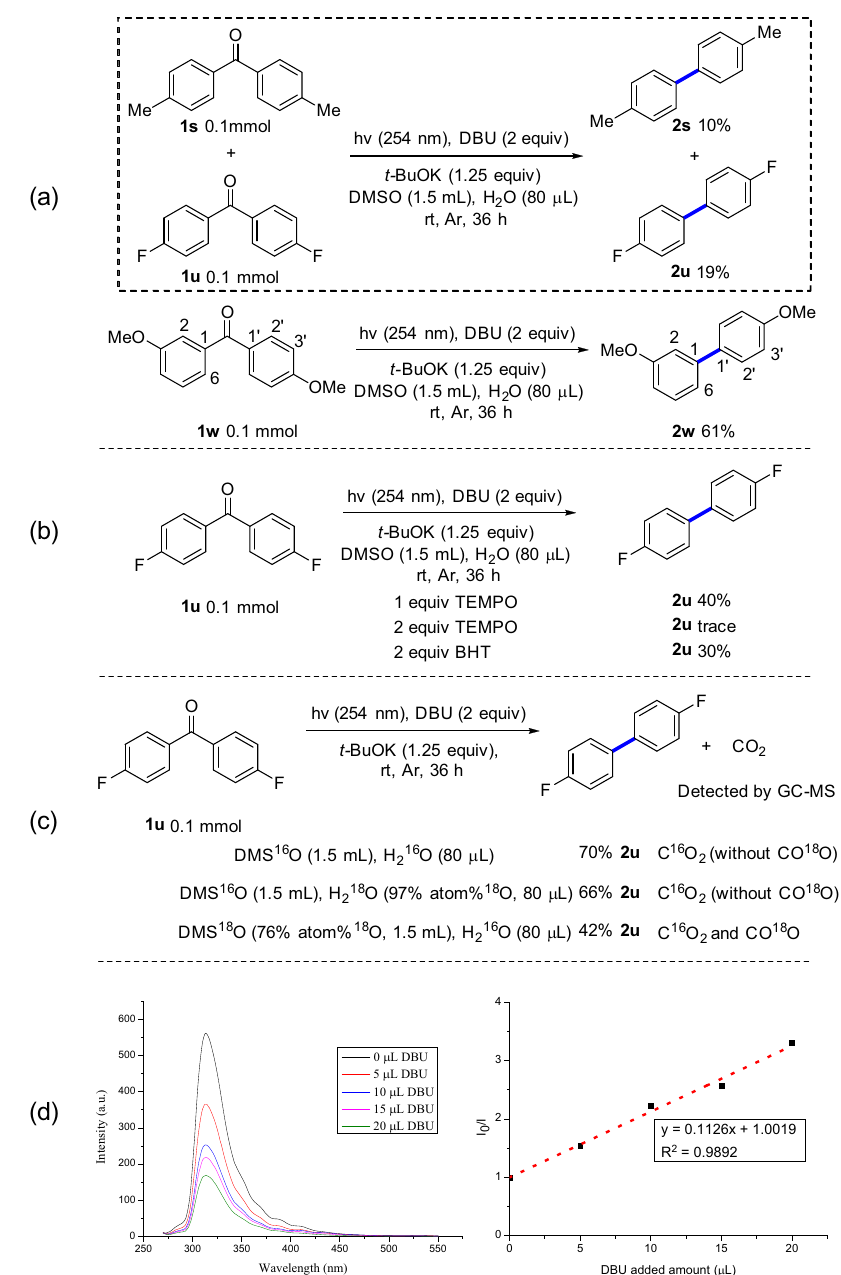
Fig. 4 Mechanistic studies. a Intermolecular and Intramolecular competition experiments. b Radical trapping experiments. c [ 18 O]-Labelling experiments. d Fluorescence quenching